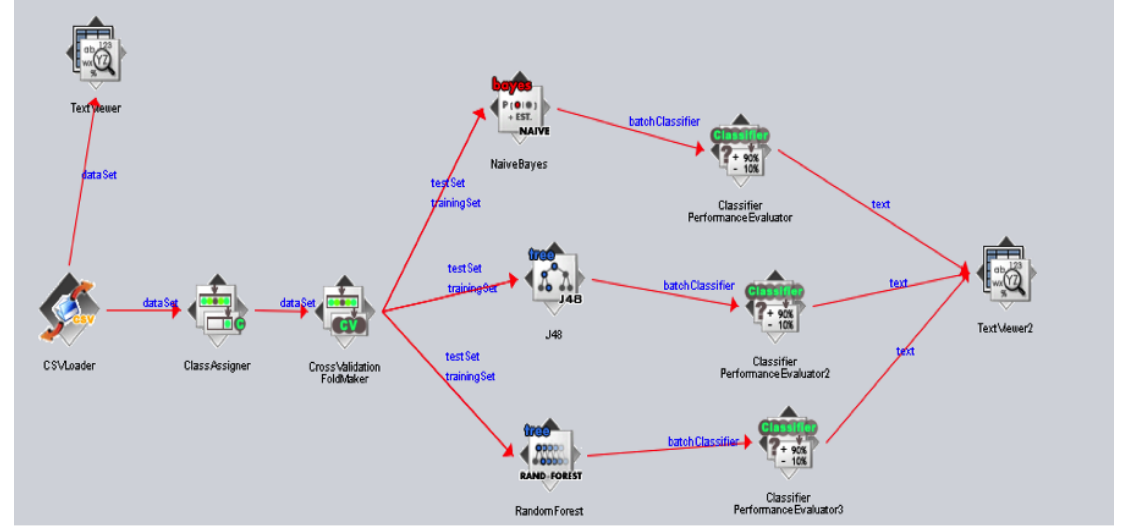
Figure 7. Traditional DM technique implementation using WEKA.